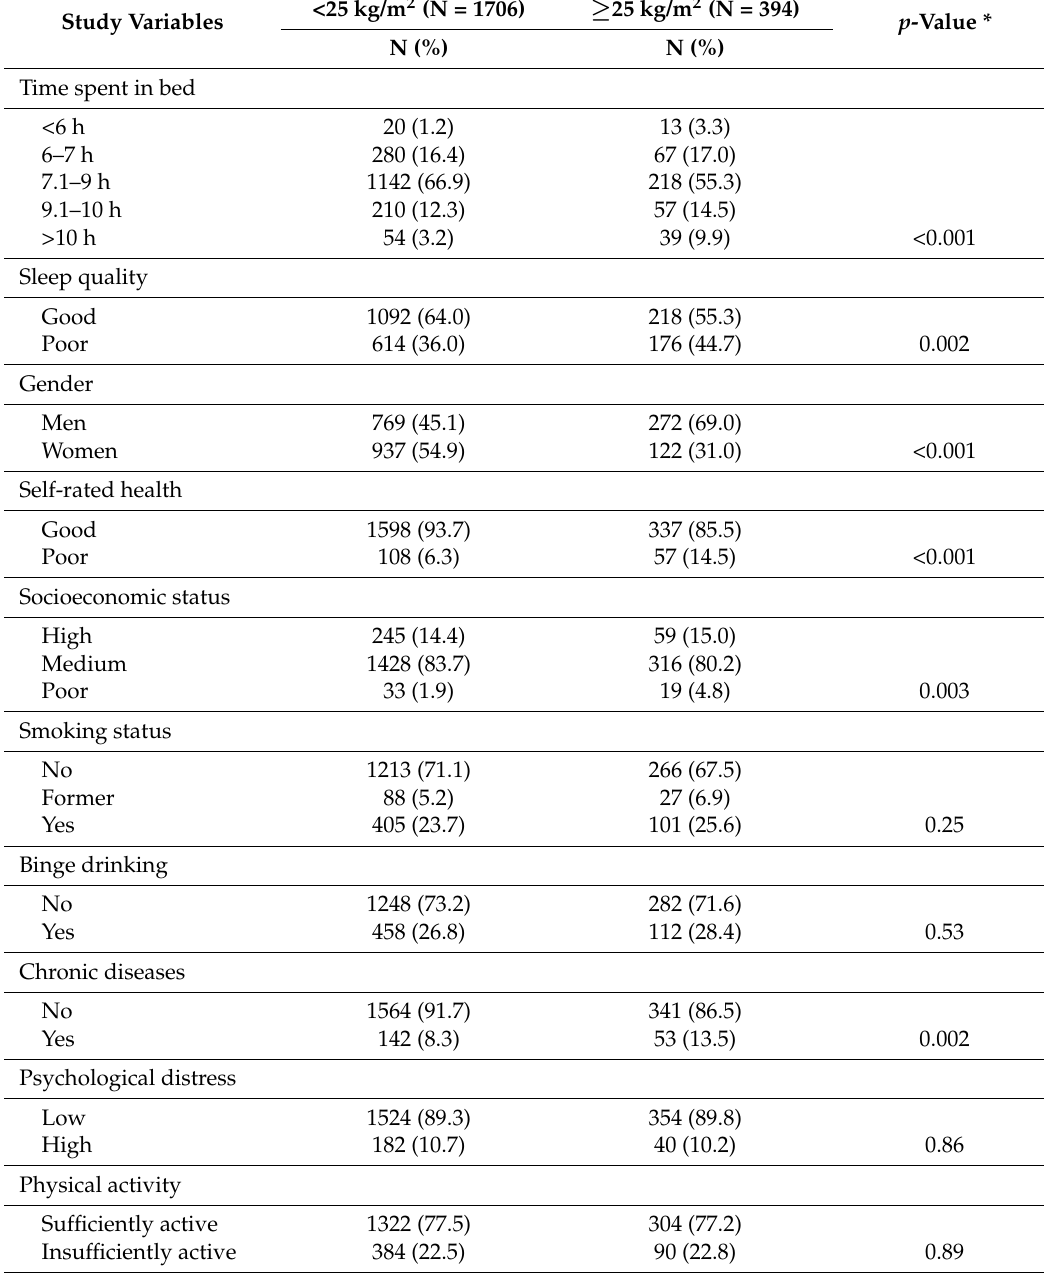
Table 1. Basic descriptive statistics of the study participants, Croatia